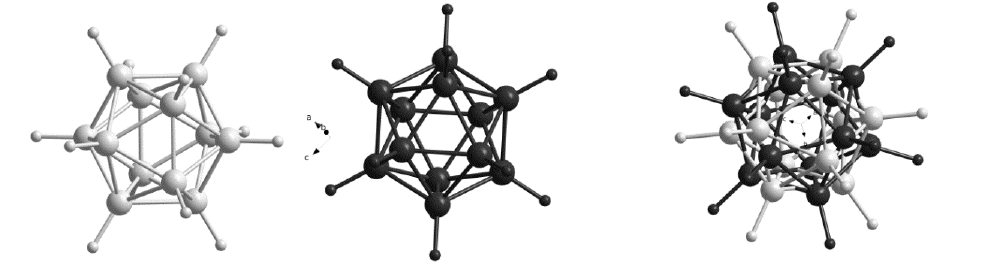
Figure 3. Two orientations, dark and light gray, of the closo -anion in the rt ordered (s.g. Pa -3) and in the ht disordered Li 2 B 12 H 12 (s.g. Fm -3) viewed along the C 3 rotation axis of the closo -anion. The rt -Cs 2 B 12 H 12 (s.g. Fm -3) contains one anion in the orientation identical to the light gray anion in rt -Li 2 B 12 H 12 , while the ht -Cs 2 B 12 H 12 (s.g. Fm -3 m ) has an identical orientation disorder (rotation around C 3 by 45°) as ht -Li 2 B 12 H 12 .